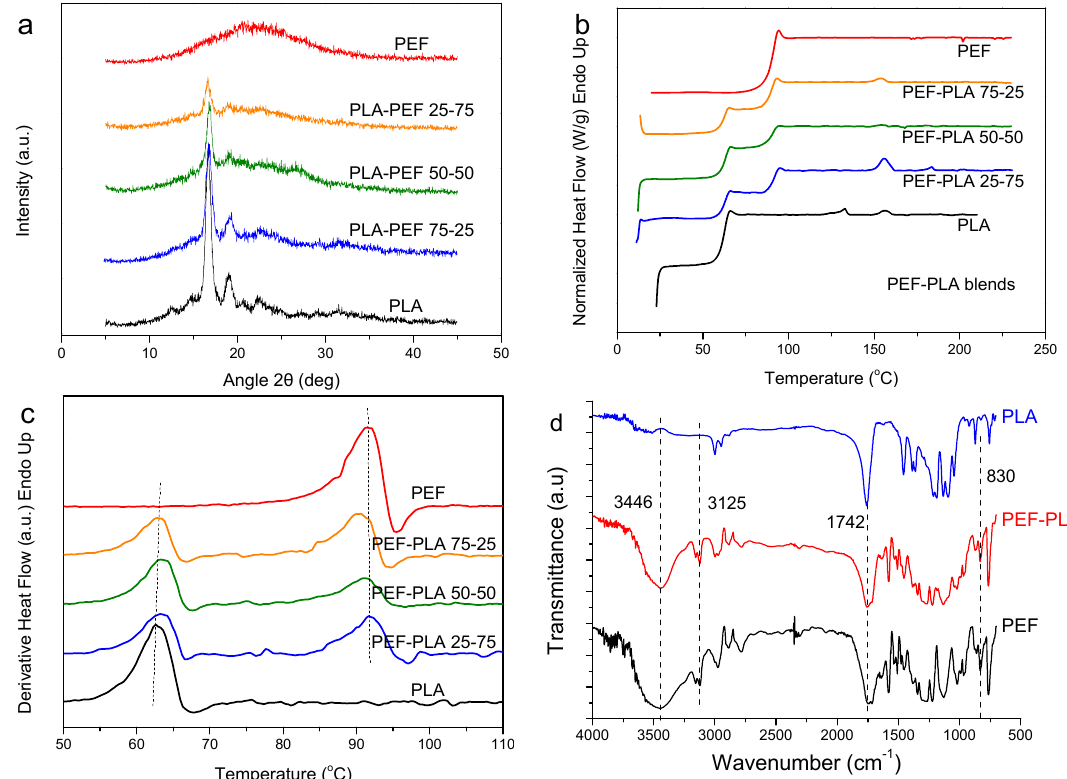
Figure 3. ( a ) WAXD patterns for as received PL–PEF blends, ( b ) DSC heating thermograms for melt-quenched PLA–PEF blend samples, ( c ) derivative heat flow for melt-quenched PLA–PEF blend samples and ( d ) FTIR spectra of neat PLA, PEF and their blends.